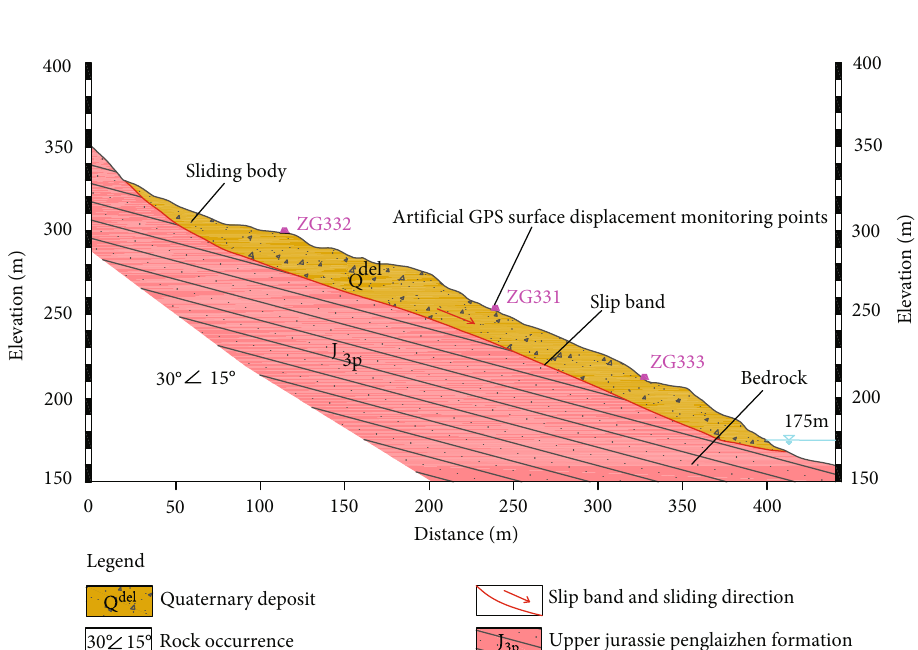
Figure 3: Layout of the Tanjiawan